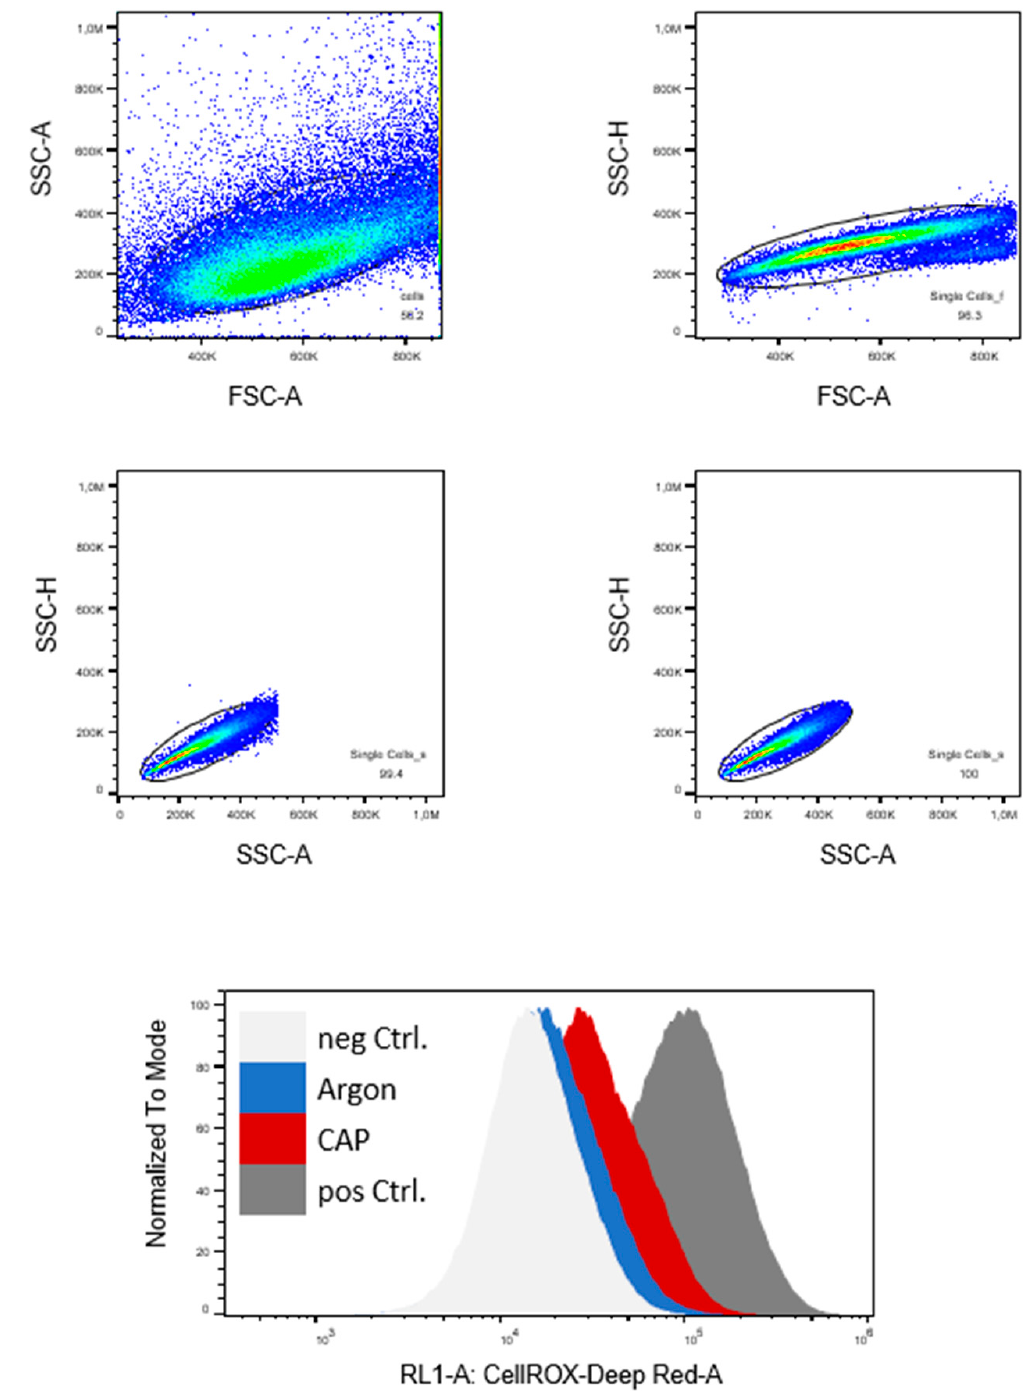
Figure 1. Human osteoblasts (HOB) and bone cancer cells (U2-OS and A673) were treated with cold atmospheric plasma (CAP) or carrier gas argon for 10 s. Controls were performed without treatment (neg Ctrl.) and with 5500 µ m H 2 O 2 . Here, U2-OS is shown as a representative example. Gating strategy: Debris and doublets were excluded by forward- and side-scatter characteristics. The mean fluorescence intensity (MFI) of CellROX deep red was compared. SSC-A: side-scatter area, SSC-H: side-scatter height, FSC-W: forward-scatter width, FSC-H: forward-scatter